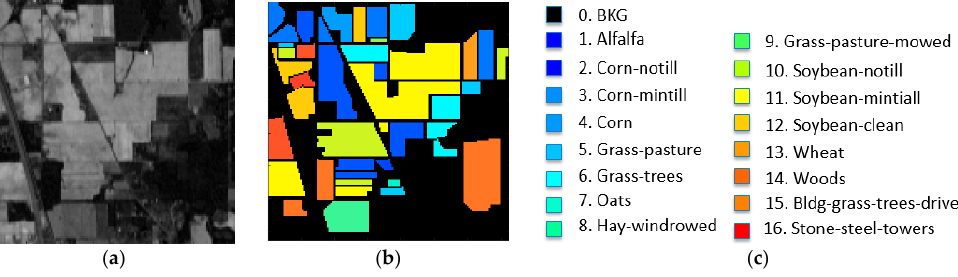
Figure 1. Purdue’s Indiana Indian Pines scene with 16 classes. ( a ) Band 186, ( b ) ground truth map, ( c ) ground truth class labels.